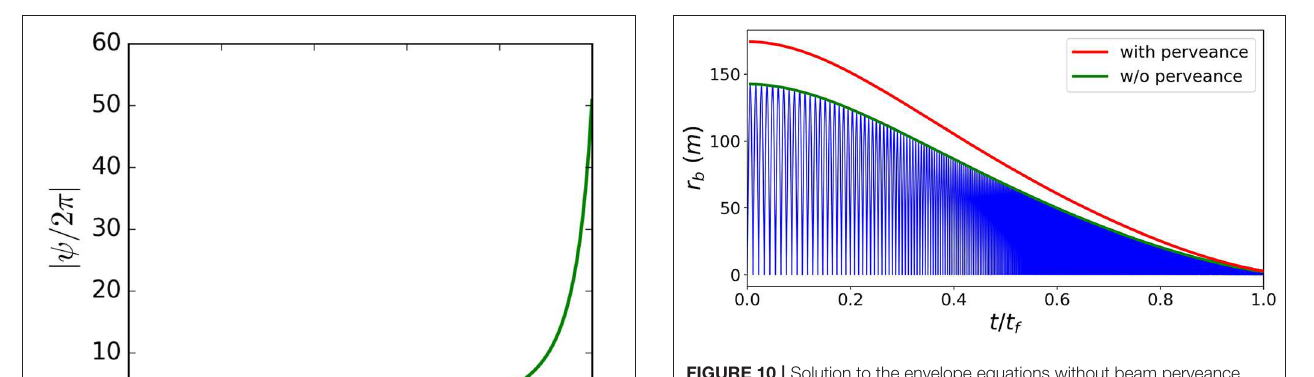
FIGURE 10 | Solution to the envelope equations without beam perveance (blue lines). Extrema solutions with (red) and without perveance (green) for the reference beam